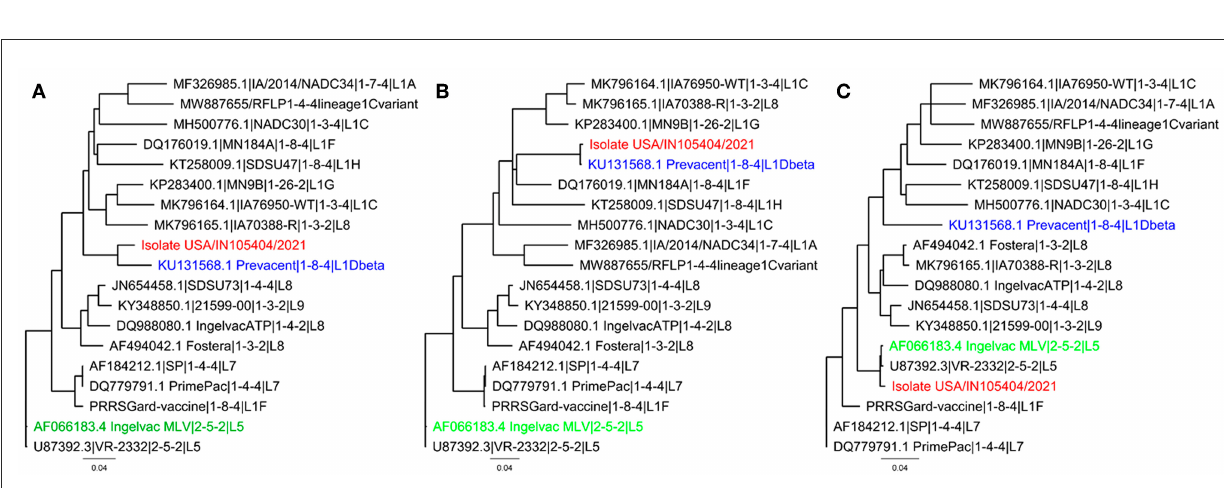
FIGURE2 Neighbor-joining phylogenetic tree representing the recombinant isolate USA/IN105404/2021 (red), the major parental strain Prevacent ® PRRS (blue), and the minor parental strain Ingelvac ® PRRS MLV (green). Strains for additional PRRSV-modified live vaccines commercially available in the United States and other PRRSV-2 wild-type strains are presented as references. (A) Whole genome neighbor-joining phylogenetic tree; (B) neighbor-joining phylogenetic tree for the genome portion before the recombination breakpoint. (C) Neighbor-joining phylogenetic for the genome portion after the recombination